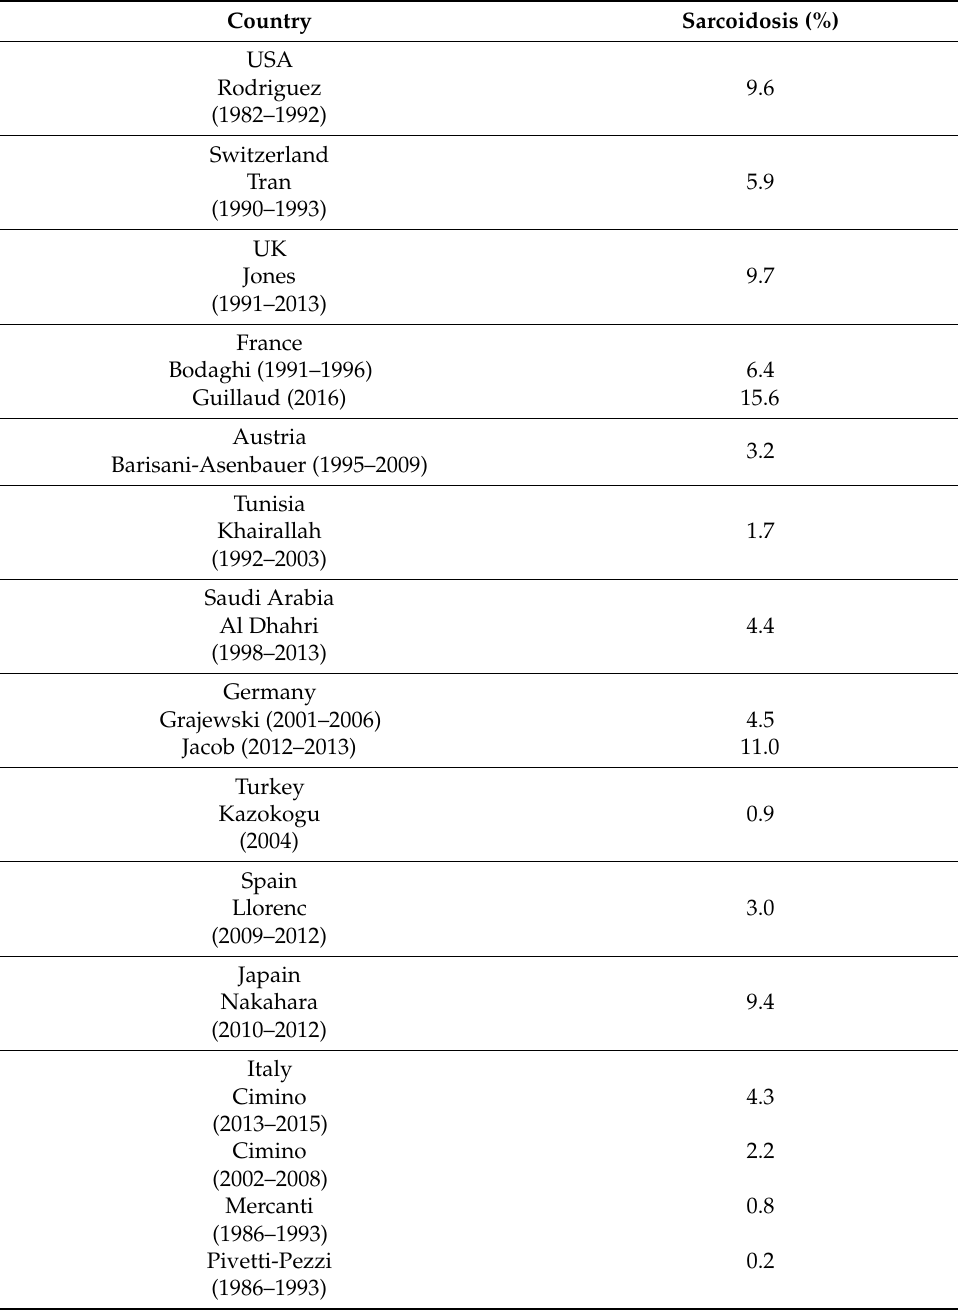
Table 9. Incidence of S among uveitis patients from previous studies modified from Cimino [39]. Country Sarcoidosis (%)